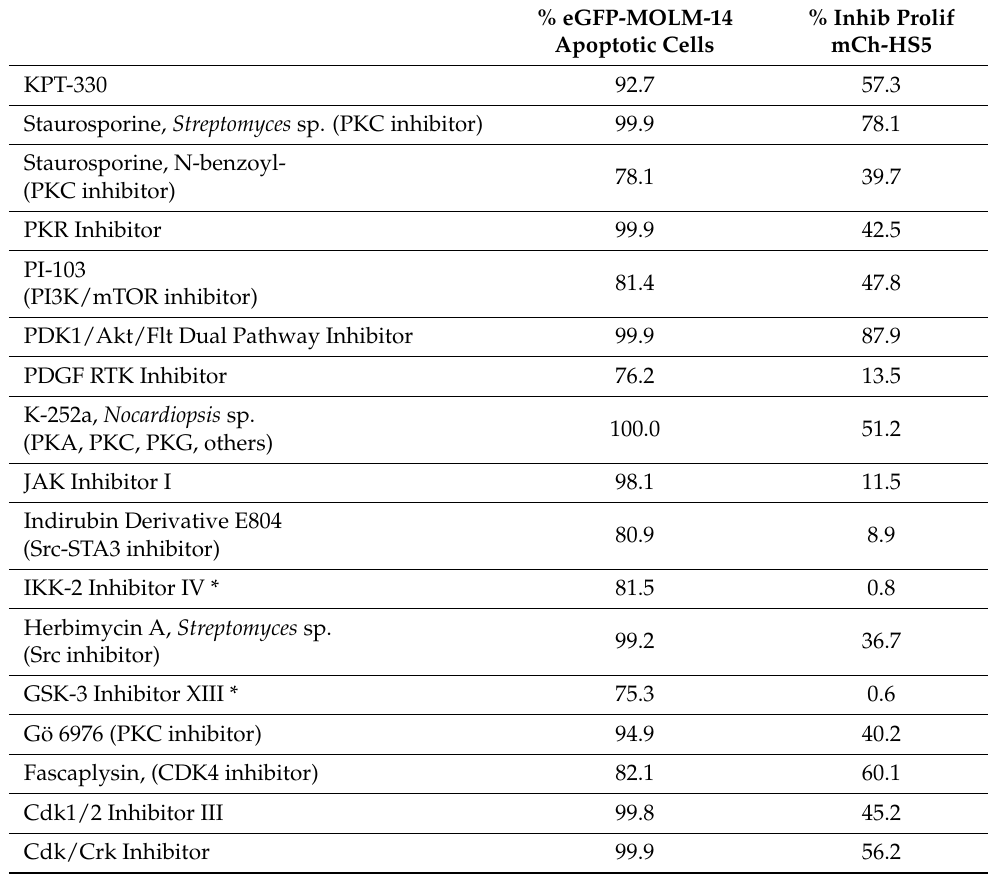
Table 1. Hit compounds that revert BM-mediated drug resistance against daunorubicin of eGFP-MOLM-14 are listed showing the percentage of apoptosis induced on eGFP-MOLM-14 and the percentage of inhibition of mCherry-HS5 cells in co-culture and treated with daunorubicin. (*) Compounds labelled with asterisks partially fulfilled the selection